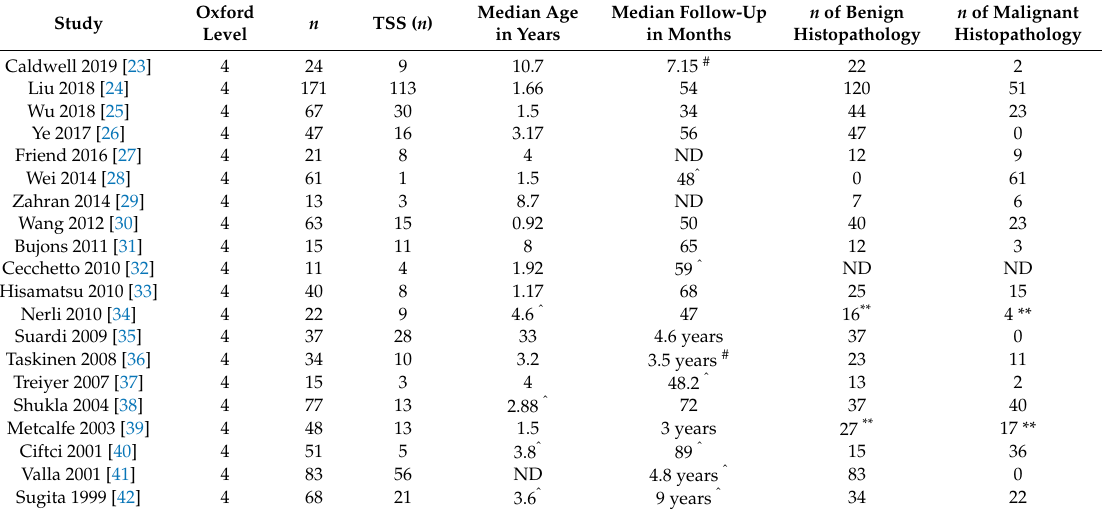
Table 1. Characteristics of the included